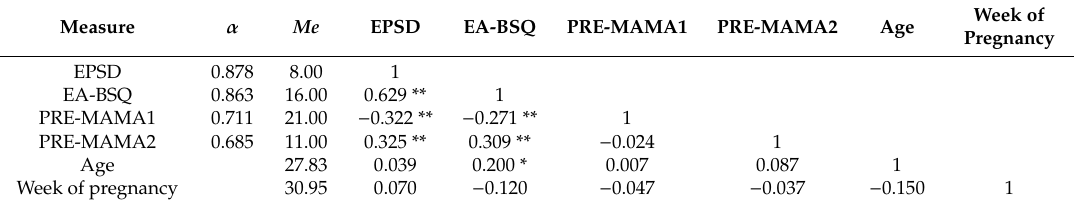
Table 3. Median, reliabilities, and intercorrelations between the study variables.